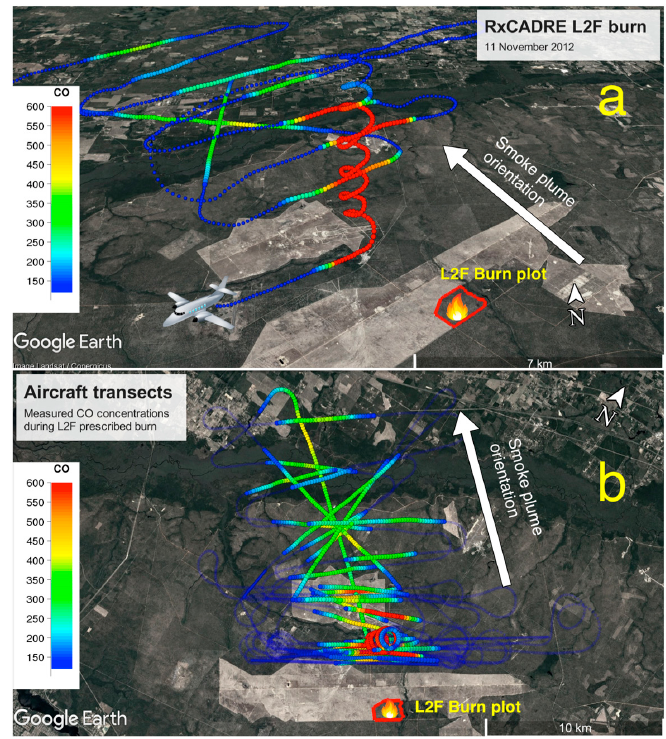
Figure 2. ( a ) 3-D image of the RxCADRE L2F prescribed on 11 November 2012. The L2F burn plot is outlined in red, and colored circles indicate aircraft measured CO (ppb) from 17:42–20:50 UTC. ( b ) Overhead (2-D) view of the same aircraft measurements in ( a ), but for 1742 through 2050 UTC. In addition, background concentrations (<120 ppb) have a transparency of 50% in order to highlight smoke enhanced smoke concentrations.